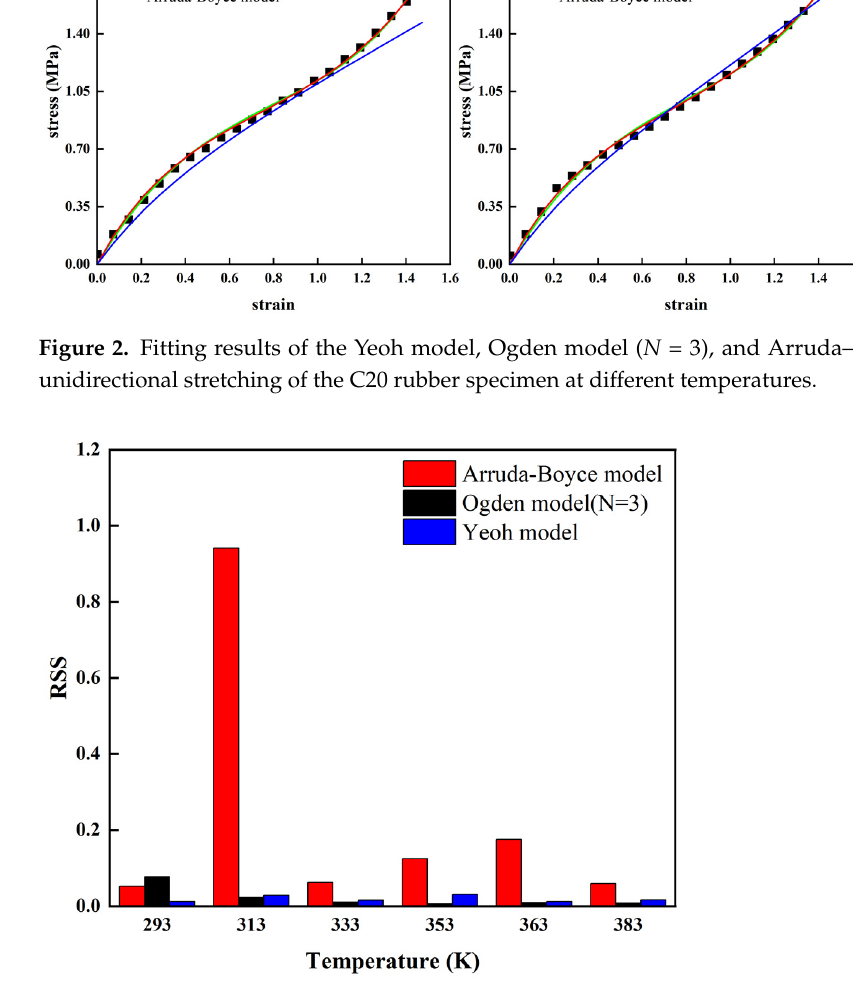
Table 2. Parameters fitting of the Ogden constitutive model ( N = 3) with the experimental data of the C20 rubber specimen at different temperatures.